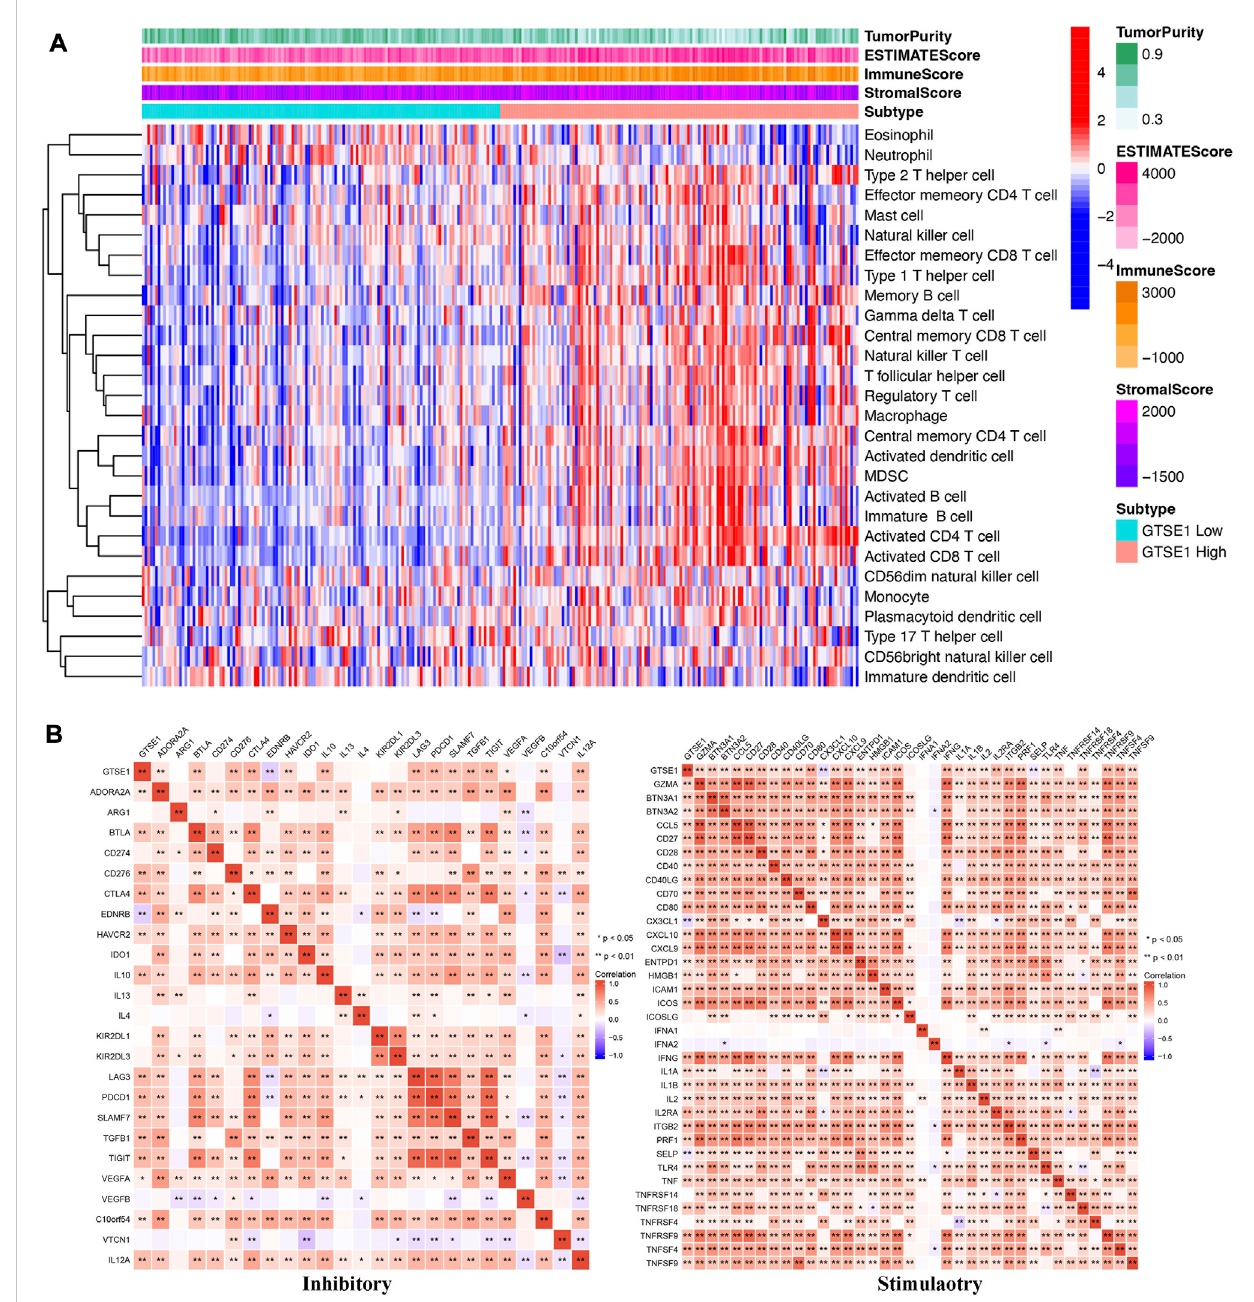
FIGURE 8 Association between GTSE1 expression and immune in fi ltration and immune checkpoints in ccRCC. (A) The correlation between the immune in fi ltration level and GTSE1 expression in ccRCC patients was evaluated and analyzed based on the combination of Estimate analysis and ssGSEA. (B) Heatmaps of the correlation between GTSE1 expression and immune checkpoints (immunoinhibitors, immunostimulators) based on the TCGA-KIRC dataset. * p < 0.05, ** p <